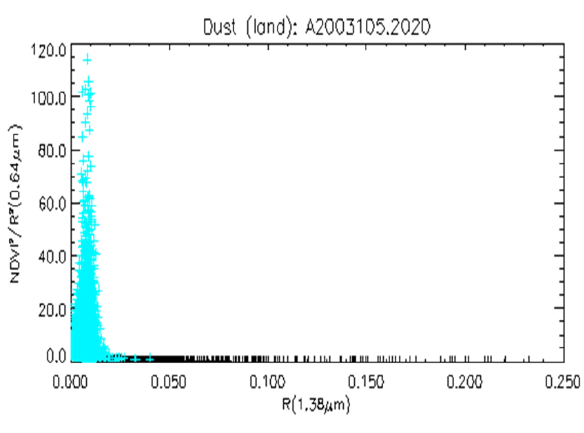
Figure 5. Scatter plot of MNDVI= NDVI 2 /(R (light-blue crosses) and dust (black